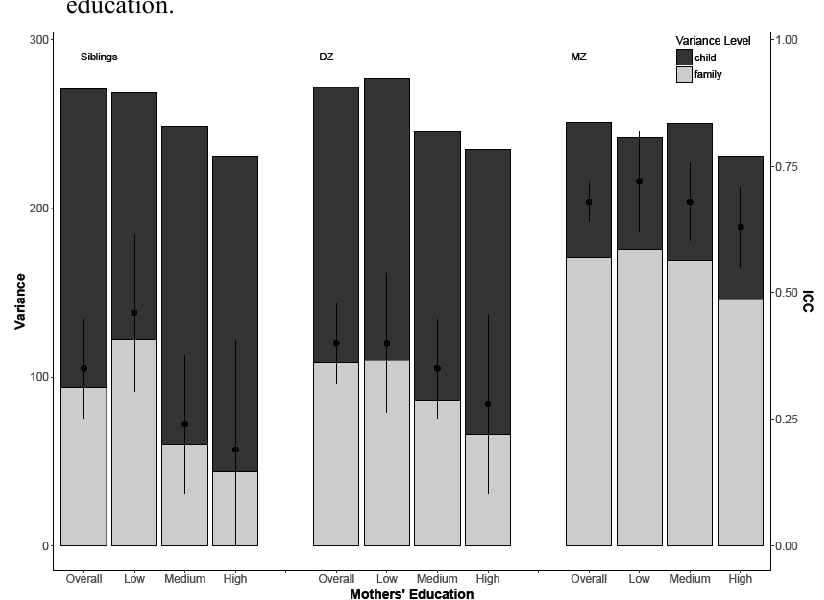
Table A3 : Sibling and twin similarity in cognitive ability according to mothers’